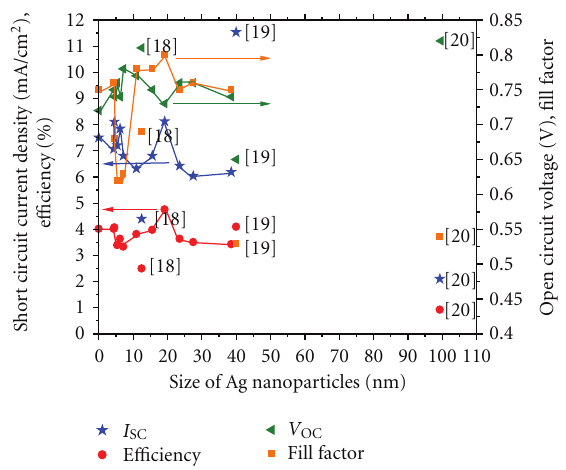
Figure 7: Open circuit voltages ( V OC ), short circuit current densities ( J SC ), fill factors (FF), and e ffi ciencies of the DSCs with varied sizes of the Ag nanoparticles compared with reported DSCs [18–20]. At [18], use 2 μ m of TiO 2 thickness and size of 0.25 cm 2 , [19] use 15 μ m of TiO 2 thickness and size of 0.25 cm 2 , [20] use 8.1 μ m of TiO 2 thickness and size of 4.0cm 2 , and this study uses 13.8 μ m of TiO 2 thickness and size of 0.6cm 2 .